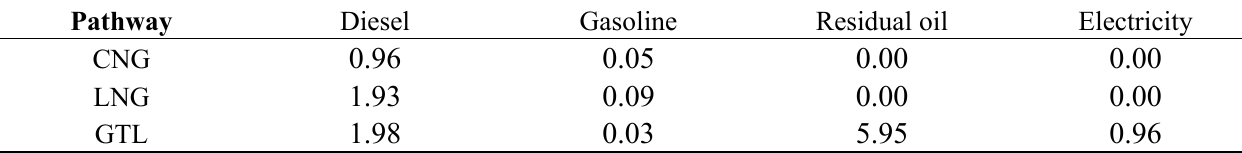
Table 6. Process fuel consumption for NG-based fuel transportation (kJ/MJ through).